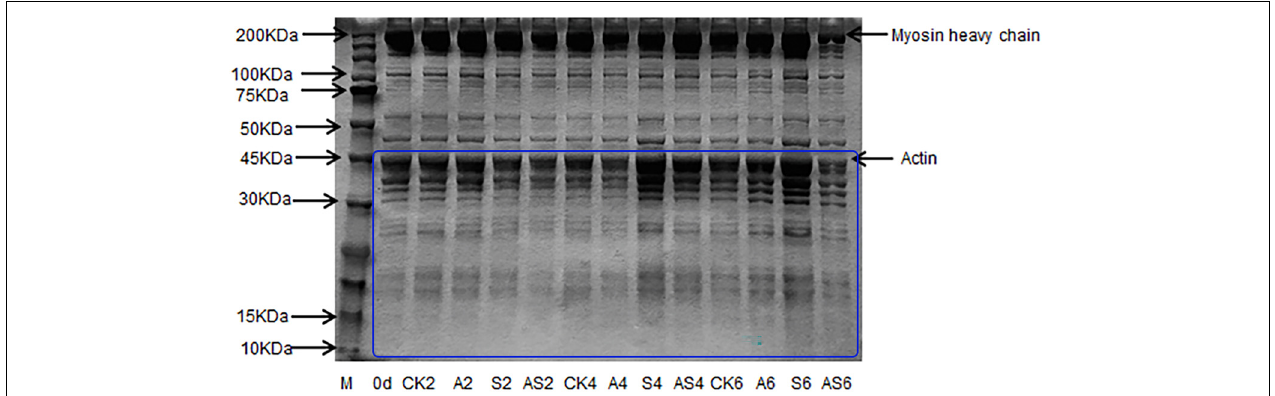
FIGURE 4 | SDS-PAGE of myofibrillar protein of bigeye tuna muscle with different bacterial groups during storage at 4 ◦ C. M: molecular weight markers. Lane 0 day: tuna stored for 0 days; lanes CK2, CK4 and CK6: tuna stored for 2, 4, and 6 days at 4 ◦ C in the control group; lanes A2, A4, and A6: tuna stored for 2, 4, and 6 days at 4 ◦ C in group A, respectively; lanes S2, S4 and S6: tuna stored for 2, 4, and 6 days at 4 ◦ C in group S, respectively; lanes AS2, AS4 and AS6: tuna stored for 2, 4, and 6 days at 4 ◦ C in group AS, respectively.